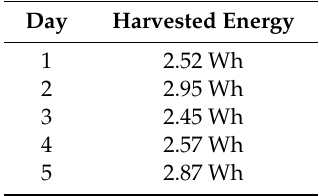
Table 9. Energy produced by the